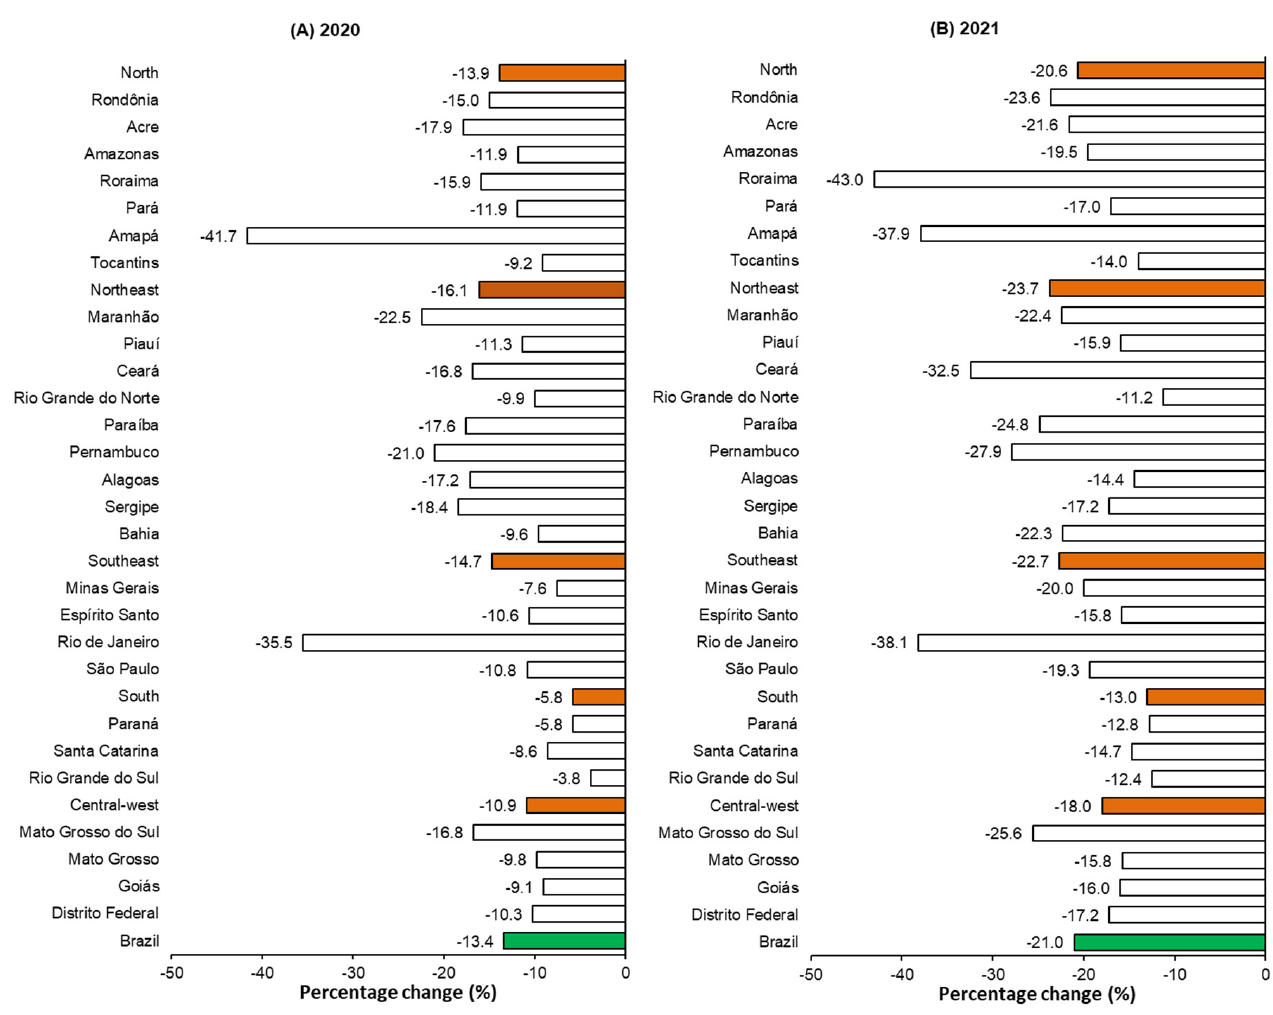
Figure 3. Impact of the COVID ‐ 19 pandemic on human rotavirus vaccination coverage during the COVID ‐ 19 pandemic in Brazil, according to Brazilian regions and states. Brazil, 2015–2021. Figures ( A , B ) show the impact of the COVID ‐ 19 pandemic on human rotavirus vaccination coverage by region and state in the years 2020 and 2021.